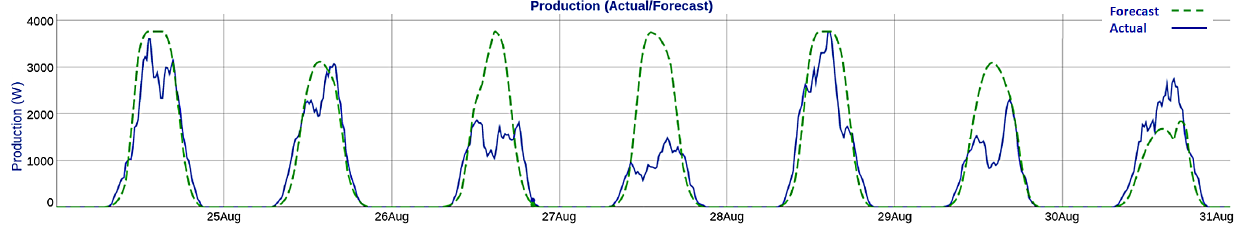
Figure 2. Comparison of actual and predicted